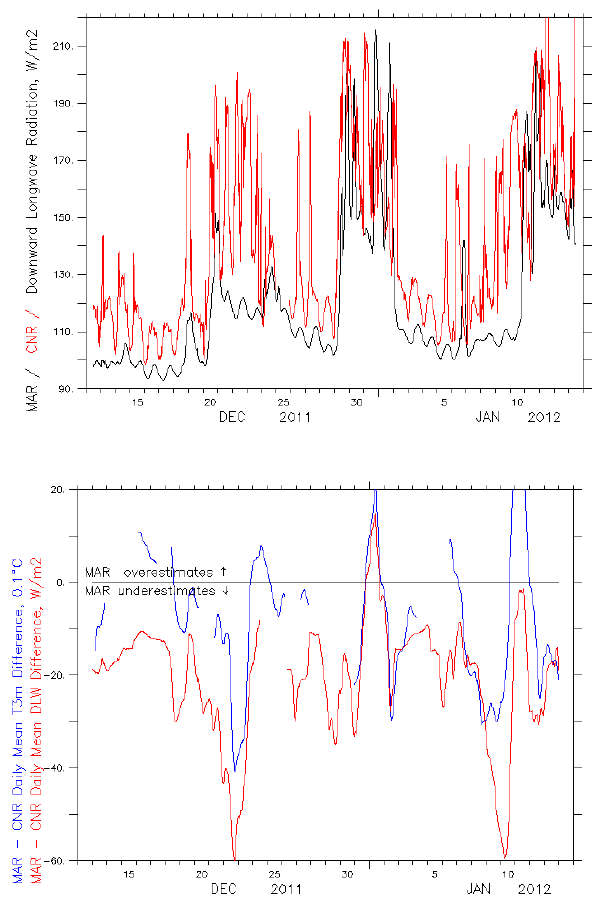
Figure 2. Top: long-wave downward radiation (LWD, Wm − 2 ): simulation (dark line) and observation (red line). Data were aver- aged over an interval of 30min. Bottom: comparison between the daily averaged LWD bias (red line) and air temperature bias (blue line, units: 0.1 ◦ C). Observations are those of the ISAC. MAR tem- peratures are averaged between 2m and 4ma.g.l. Gaps correspond to the absence of